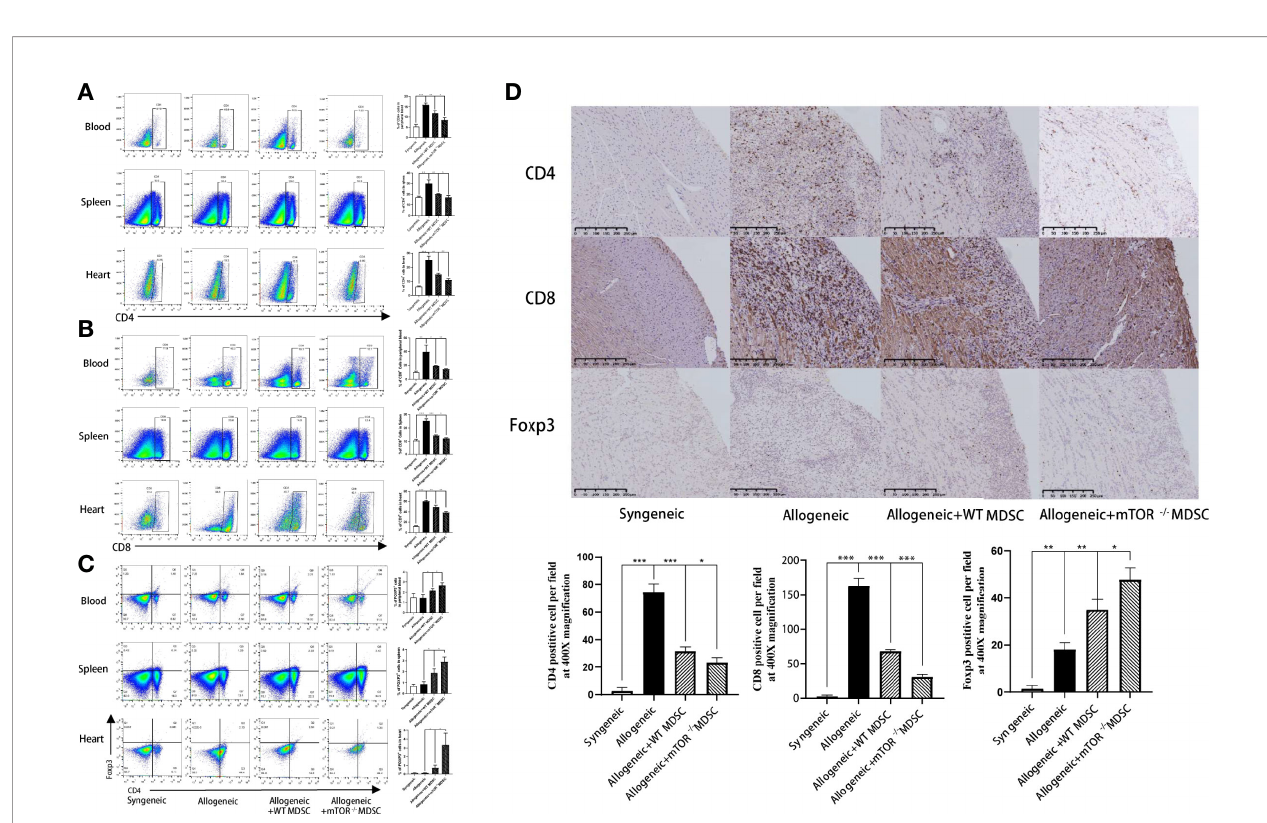
FIGURE 6 | Infusion of mTOR − / − M-MDSCs reduced CD4 + and CD8 + T cells and increased Tregs in blood, spleen, and heart. (A) Proportion of CD4 + , CD8 + T cells, and Foxp3 + Tregs in blood. (B) Proportion of CD4 + , CD8 + T cells, and Foxp3 + Tregs in spleen. (C) Proportion of CD4 + , CD8 + T cells, and Foxp3 + Tregs in heart. (D) CD4, CD8, and Foxp3 immunohistochemistry staining in cardiac allograft with semi-quanti fi cation analysis (400×; n = 5, *P < 0.05, **P < 0.01, and ***P <